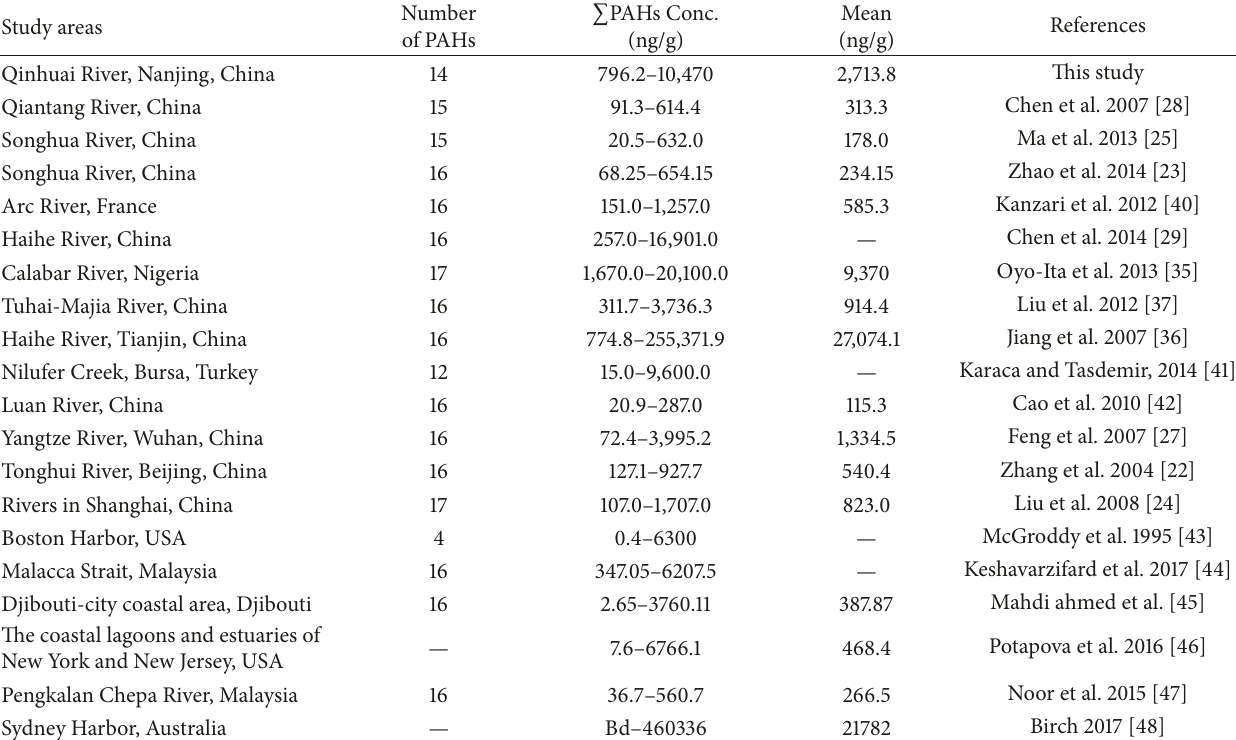
Table 3: Sediment PAHs concentrations reported from